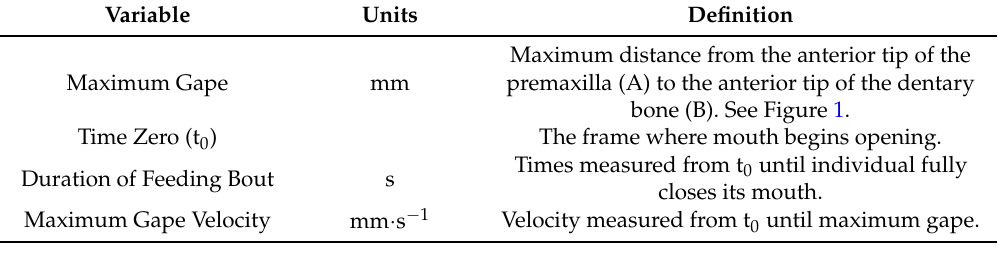
Table 1. Linear excursion, velocity, and timing variables and measurements defined when analyzing videos taken of juvenile alligators.